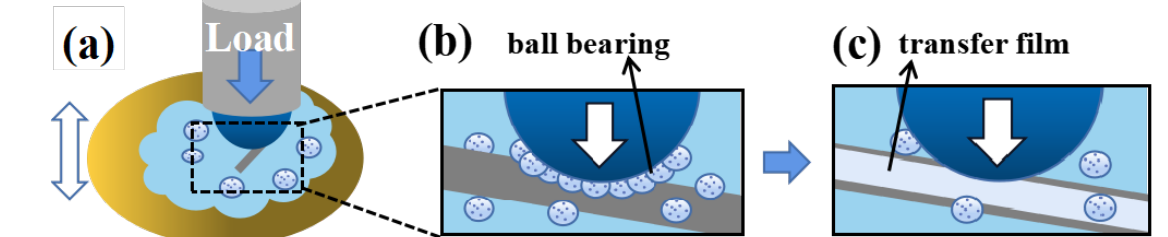
Figure 10. Schematic diagram of ( a ) friction performance test and ( b , c ) lubrication mechanism for the PTFE/PS water-based lubricant.